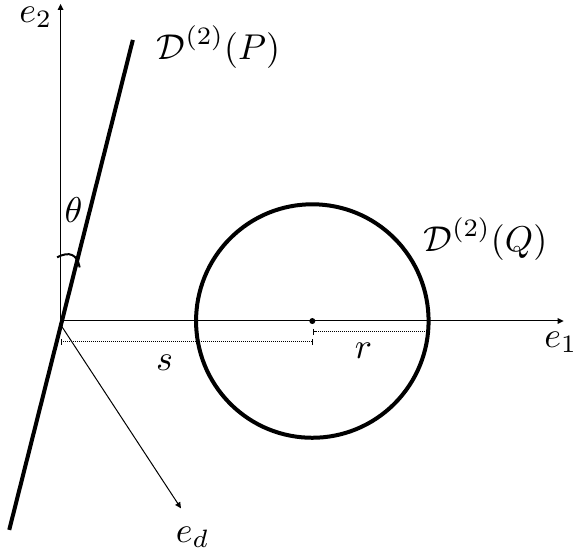
Figure 6 . A canonical con(cid:12)guration of two co-dimension 2 defects. One of them is a sphere of radius r sitting at se 1 in the hyperplane transverse to e d . The other one is (cid:13)at and is tilted by an angle (cid:18) in the e 2 (cid:0) e d